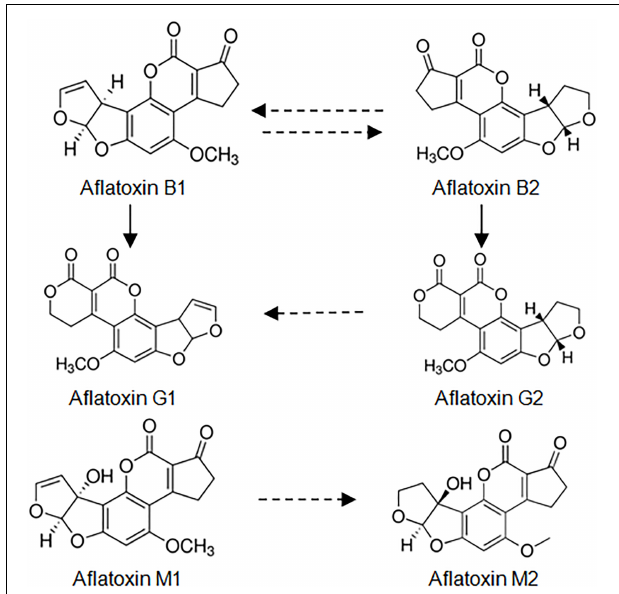
FIGURE 1 | Transformation of